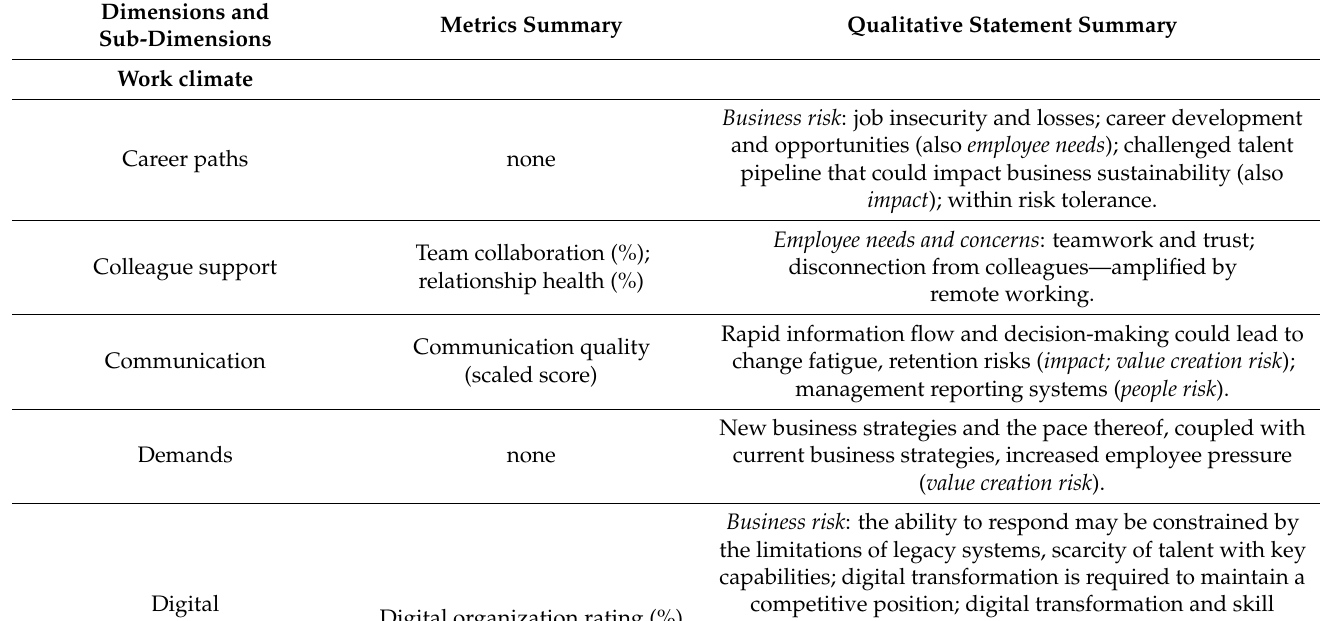
Table 4. Category 2: Risks reported—Metrics and qualitative